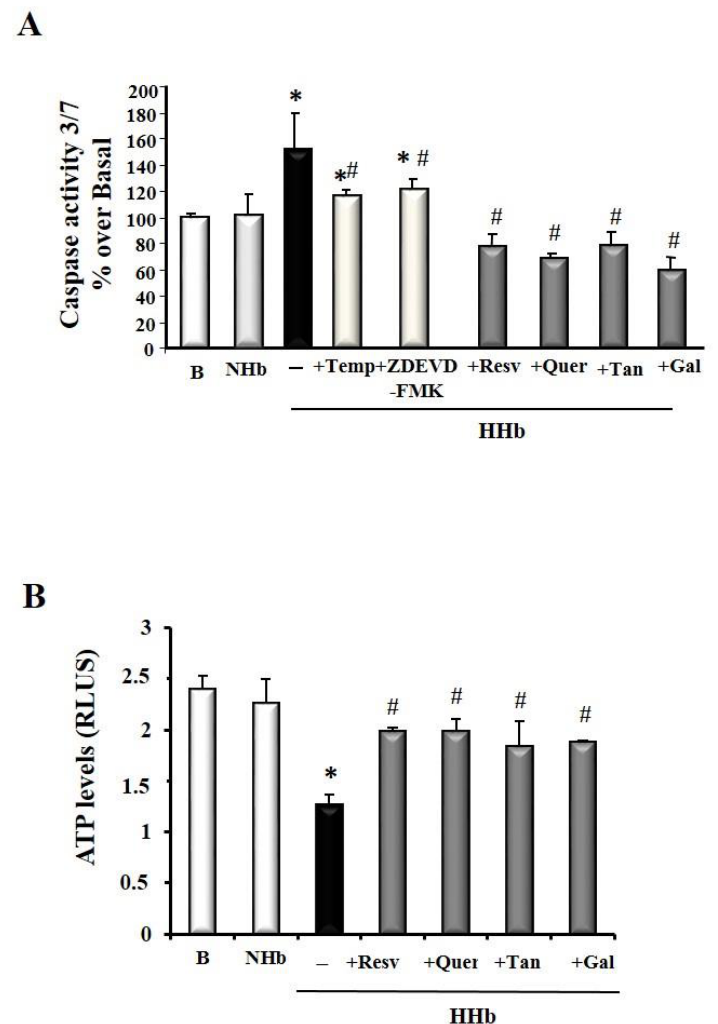
Figure 3. Polyphenols inhibit apoptosis induced by Amadori adducts in HPMCs. ( A ) Caspase 3 / 7 activity in whole cell lysates; ( B ) ATP levels measured by a luminescent assay in HPMCs. Cells exposed for 24 h to di ff erent Amadori adducts, HHb and NHb (10 nM), polyphenols: resveratrol (Resv, 12.5 µ M), tannic acid (Tan, 10 µ M), quercetin (Quer, 10 µ M), gallic acid (Gal, 10 µ M); Tempol (Temp, 100 µ M) a ROS scavenger and ZDEVD-FMK (100 µ M), a specific caspase-3 inhibitor. For each experiment, 10 independent cultures of HPMCs were used, corresponding to 10 donors. Data represent means ± SD of 7 independent experiments (for each culture of HPMCs corresponding to each of the 10 donors), ( A ) in % and ( B ) in relative light units, RLUs, * p ≤ 0.05 vs. el basal. # p ≤ 0.05 vs. HHb.